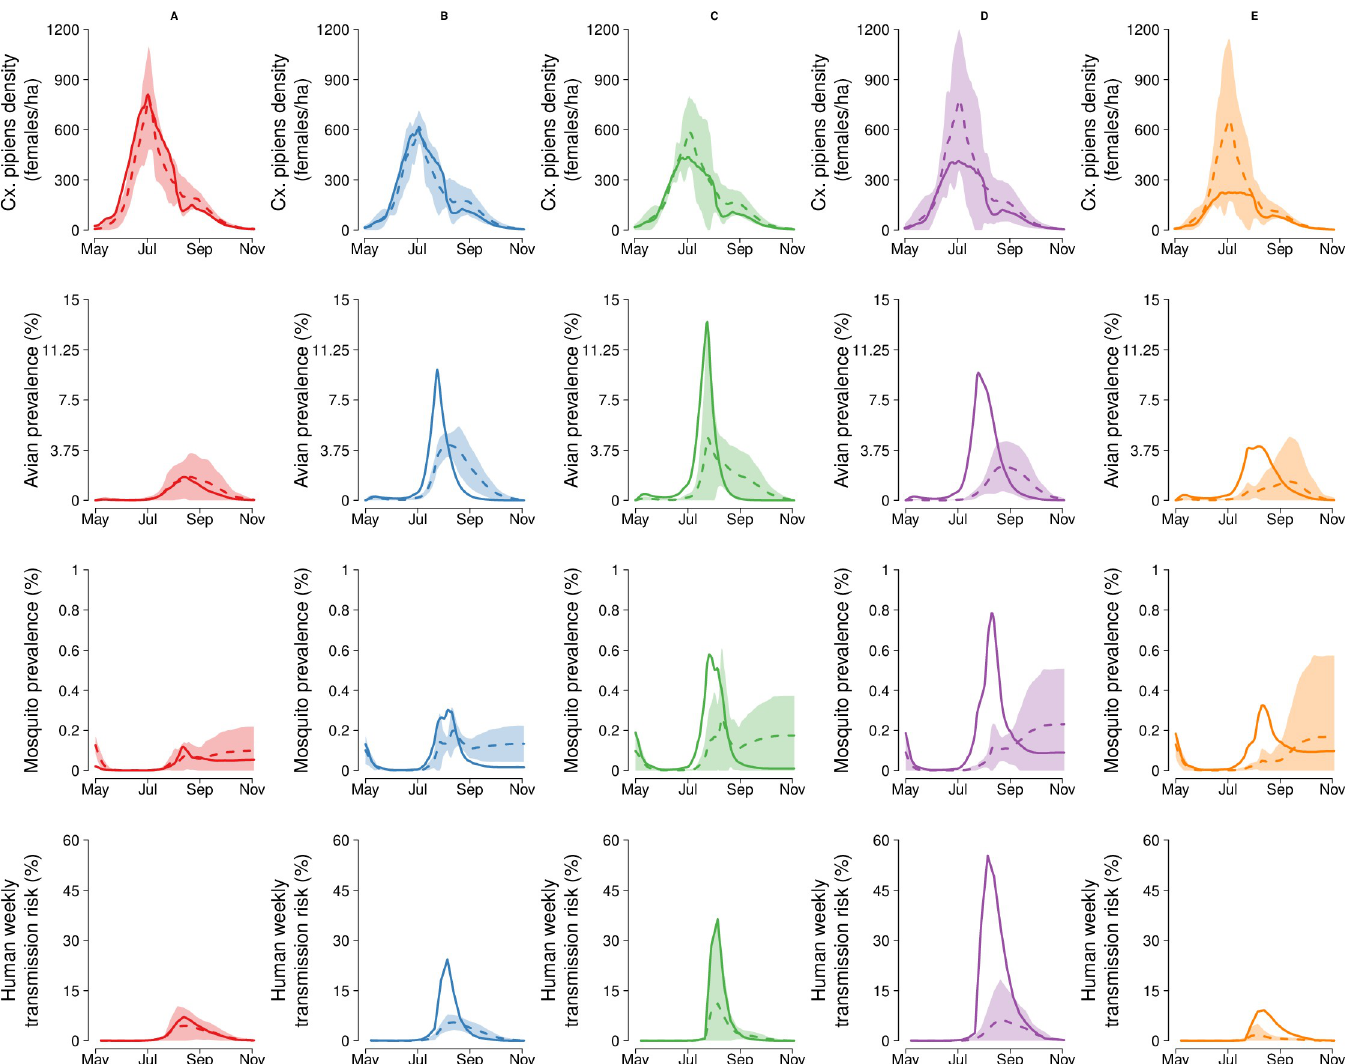
Fig 4. Comparison between 2018 and previous seasons. Comparison between 2018 (continuous lines) and averaged previous seasons (2013–2017, dashed lines, shaded areas represent the 95%CI of the averaged 2013–2017 seasons) of the mean i) estimated mosquito abundance (number of adult females per hectare, first row), ii) avian prevalence (second row), iii) mosquito prevalence (third row) and iv) λ H , the human transmission risk, (bottom row) for each cluster (A: first column, B: second column, C: third column, D: fourth column, E: last